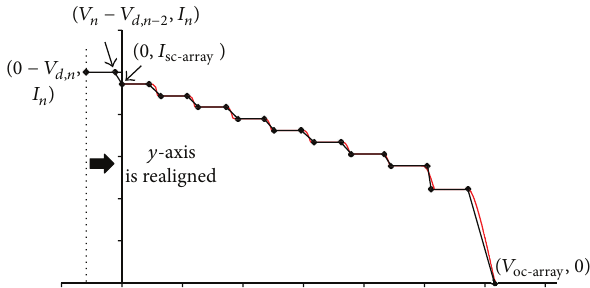
Figure 11: When some critical points lie in the negative voltage region, 𝑦 -axis should be realigned, and 𝐼 current value that crosses the axis.